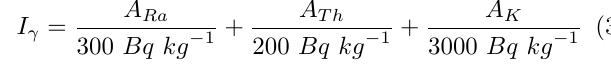
(cid:0) (cid:1) Bq kg − 1 with studied results in soil samples from some